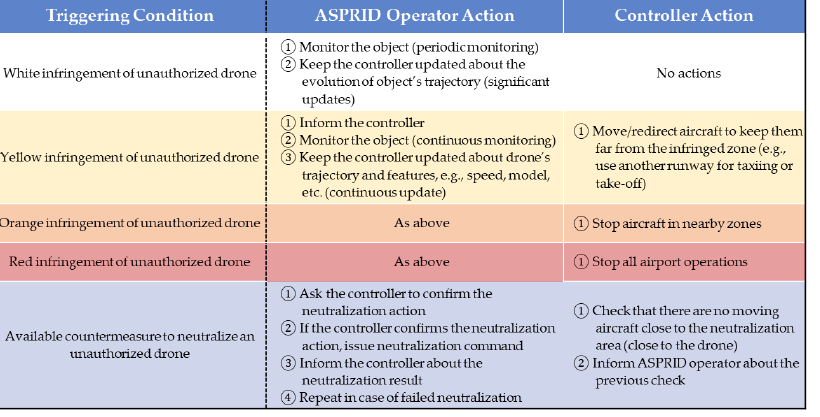
Figure 4. BPMN process diagram of ASPRID operational procedure: main process.